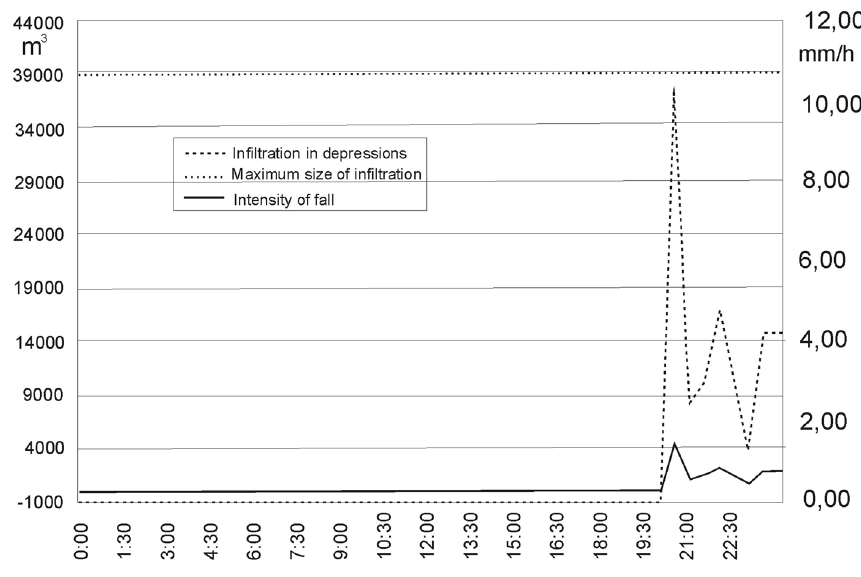
Fig. 15 Infiltration com- pared with precipitation on 12.03.2001 (Major and